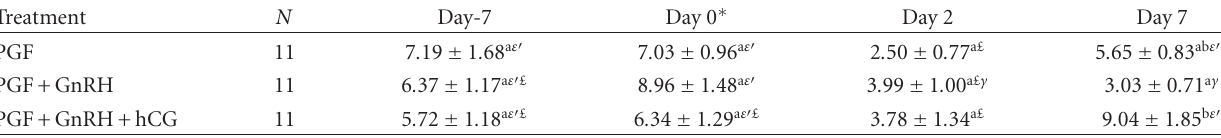
Table 2: Means and standards errors for progesterone concentrations in ovulating heifers by treatment and by day (ng/ml). Treatment